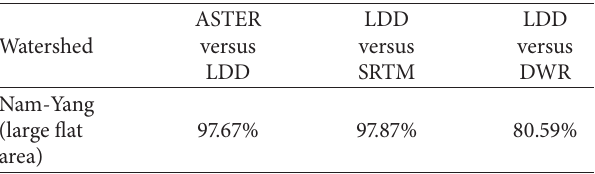
Table 8: Intersected area between various DEMs extracted from Nam-Yang subbasin.